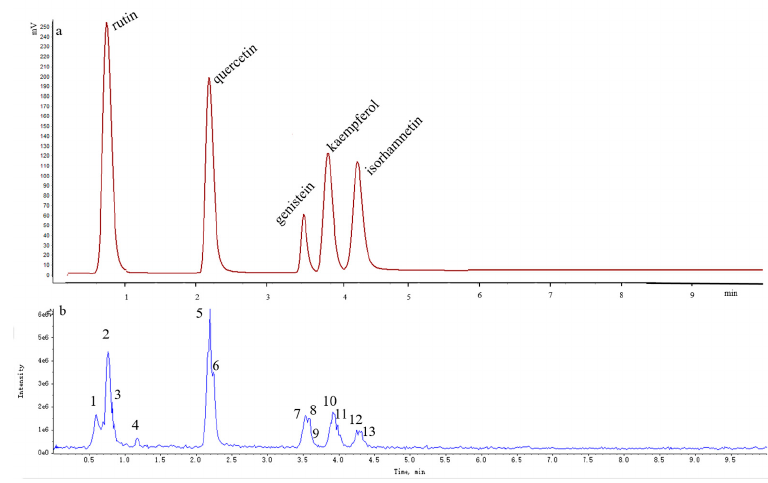
Figure 12. UHPLC ( a ) and LC-ESI-Q-TOF/MS TIC ( b ) chromatography of FSI.